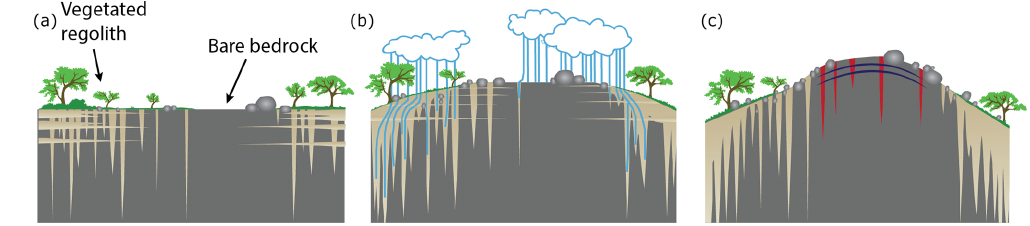
Figure 9. Schematic illustration showing the influence of bedrock fractures on landscape evolution. (a) Bedrock with different fracture densities is infiltrated to different degrees by rain and groundwater, which leads to differences in chemical weathering, soil formation, and vegetation growth, resulting in different hillslope sediment sizes. (b) Differential denudation between highly fractured and less fractured areas induces relief growth under slow but persistent uplift, which further promotes spatial gradients in chemical weathering, hillslope sediment size, and denudation. (c) Growing relief increases topographic stresses and the formation of new fractures (red) at topographically high positions (e.g., St. Clair et al., 2015) as well as unloading-related surface-parallel fractures (dark blue) (e.g., Martel, 2011), and steeper slopes allow for transportation of boulders, shown rolling down the slopes on either